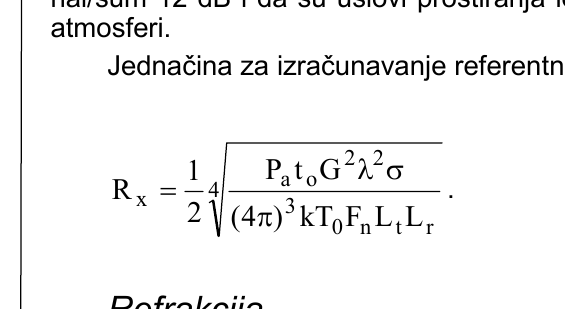
prora č unu referentnog dometa uzima se da je potreban odnos sig- nal/šum 12 dB i da su uslovi prostiranja idealni, tj. da nema slabljenja u